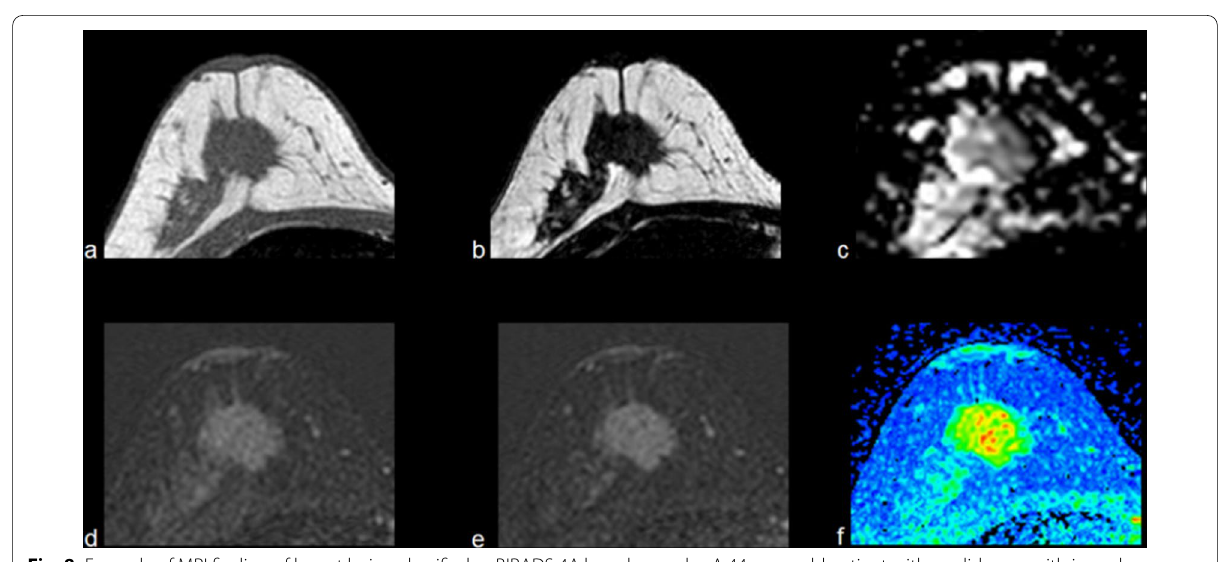
Fig. 8 Example of MRI finding of breast lesion classified as BIRADS 4A by echography. A 44‑years‑old patient with a solid mass with irregular contours at the right breast presents superior external spiculations. It appears hypointense on T1W ( a ) and T2W ( b ), and ADC ( c ) value of 0.8 10 − 3 mm 2 /s. At initial ( d ) and delayed ( e ) postcontrast subtraction images, it shows a homogeneous gradual enhancement ( f ) with a wash‑out × pattern. Thus, it was classified as BIRADS 5. The pathological analysis confirmed it as Invasive Ductal